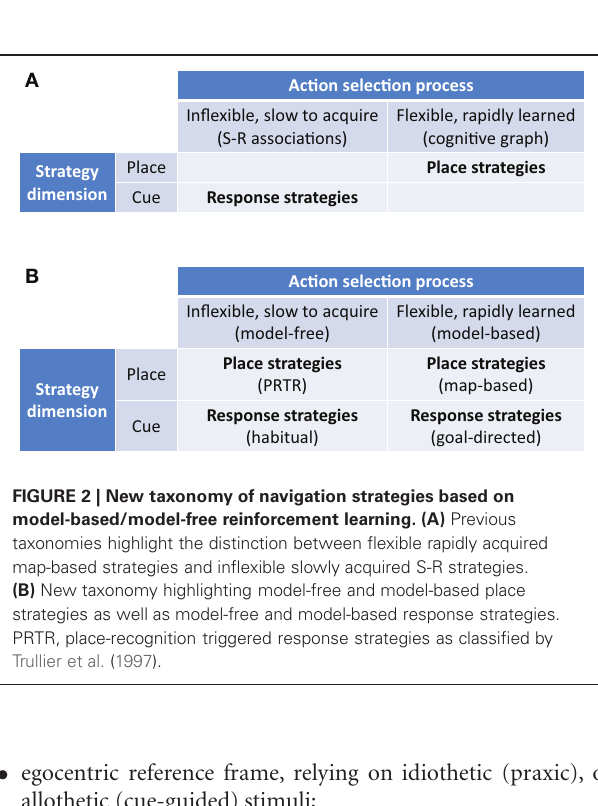
• egocentric reference frame, relying on idiothetic (praxic),